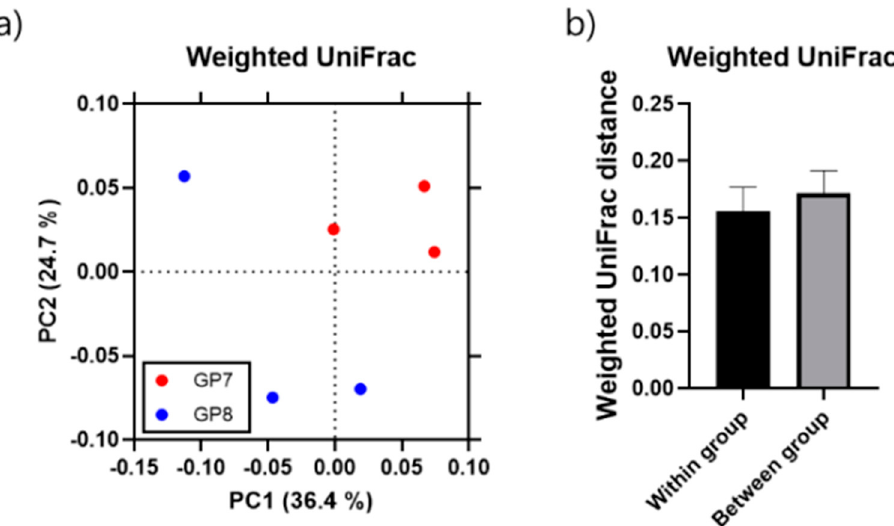
Figure 5. Weighted principal coordinates analysis (PCoA) with the first and second principal components (PC1 and PC2) explaining 36.4% and 24.7% of the variance, respectively ( a ); inter-(within) and intra-(between) diversity analysis between two sampling sites and among three samples from each site, respectively, and data are presented as mean ± standard deviations ( b ).